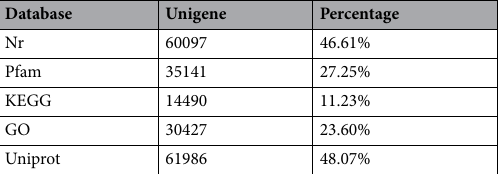
Table 2. Unigene homology searches against biological